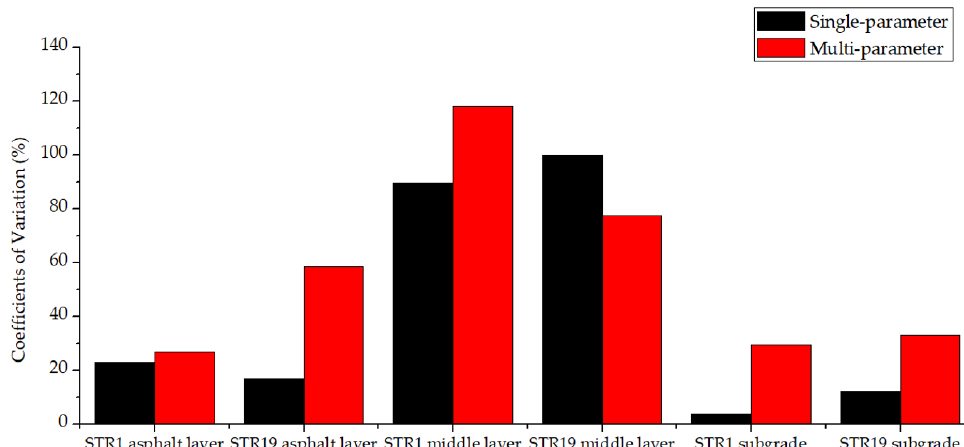
Figure 16. The coefficients of variation.